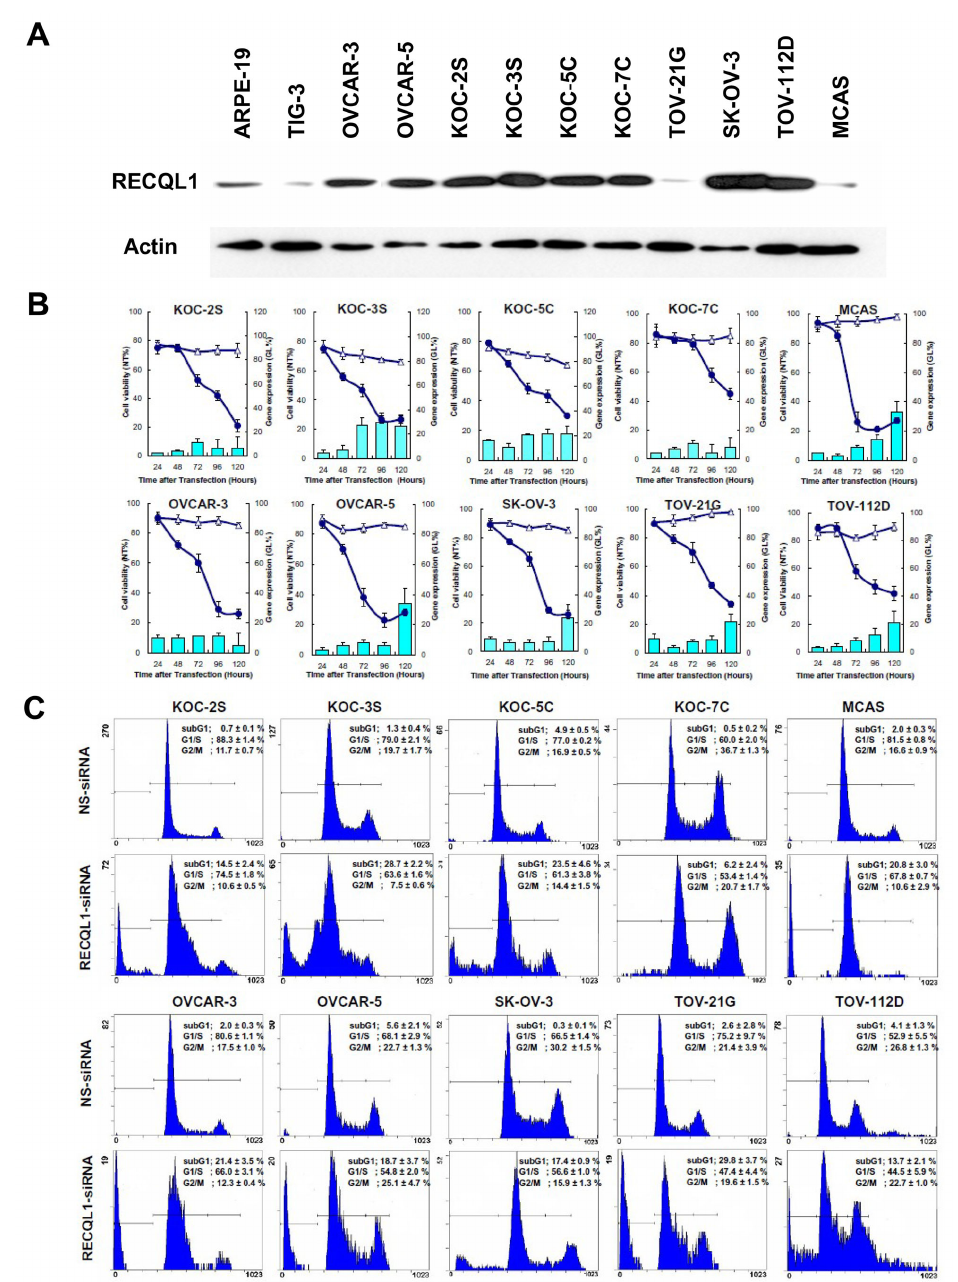
Figure 3. In vitro analysis on RECQL1 expression. (A) RECQL1 expression levels in ten OC cell lines. RECQL1 expression was found to be exceptionally high in KOC-2S, KOC-3S, OVCAR-3, OVCAR-5, KOC-7C, SK-OV-3 and Tov-112D ovarian cancer cell lines as compared with the two normal cell lines (ARPE-19 and TIG-3). (B) The effect of RECQL1 silencing on the growth of OC cell line by time-course analysis. A total of ten OC cell lines were transfected with either RECQL1-siRNA (solid circle) or NS-siRNA (triangle) for a period of 120 hours as described in the Materials and Methods. Cell viability decreased with time after siRNA treatment. RECQL1-siRNA significantly inhibited the proliferation of a wide range of OC cell lines in accordance with the reduction of RECQL1 mRNA (shown as histograms). During the time-course, RECQL1 mRNA expression was reduced differentially, depending on cell line. Data represent the means ± SD, n = 3. (C) The effect of RECQL1 silencing on the cell cycle of OC cell line measured by flow cytometric analysis. Cell lines were transfected with either NS-siRNA (Upper panels) or RECQL1-siRNA (lower panels) for 72 hours. The percentage of cell populations in the subG1, G1/S and G2/M stages are shown as mean ± SD in each flow cytometric profile. doi: 10.1371/journal.pone.0072820.g003 PLOS ONE |